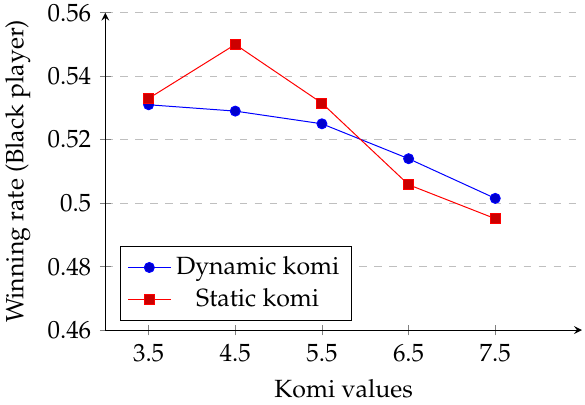
Figure 2. Komi variation versus winning probability in